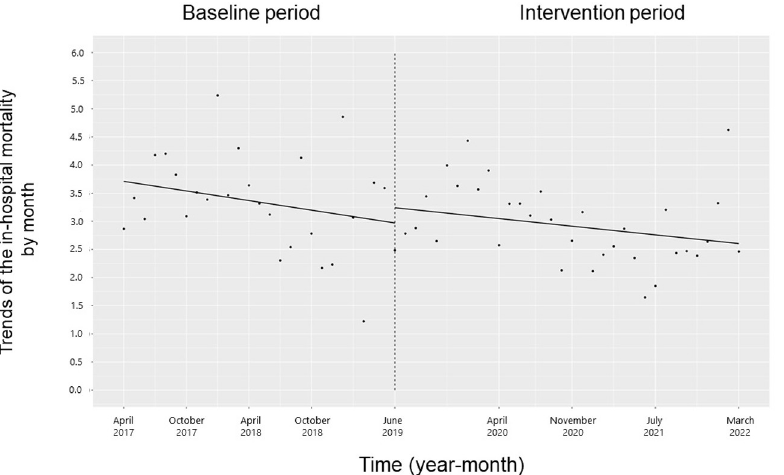
Fig 12. Trends in in-hospital mortality by month during the pre-intervention period (Phase 1) and interventional period (Phases 2–4). Each dot refers to the in-hospital mortality each month, and the slope is based on the linear regression in the four phases: Phase 1 (pre-intervention period from April 1, 2017, to May 31, 2019); Phase 2 (review of clinical pathways from June 1, 2019, to March 31, 2020); Phase 3 (establishing an infectious disease (ID) consultation service and implementing the antimicrobial stewardship program from April 1, 2020, to June 30, 2021); and Phase 4 (educational lecture and pop-up displays for oral antimicrobials from July 1, 2021, to March 31, 2022). https://doi.org/10.1371/journal.pone.0281518.g012 treat immune-related adverse events associated with immune checkpoint inhibitors and drug- induced pneumonia. This is a high-risk factor for Pneumocystis jirovecii pneumonia and a pos- sible reason for the frequent use of trimethoprim-sulfamethoxazole for its prevention and treatment in our cancer center [29]. The monthly DOT for macrolides showed a decreasing trend from Phases 1 to 2 and 3 to 4, and the level decreased from Phases 2 to 3. The change